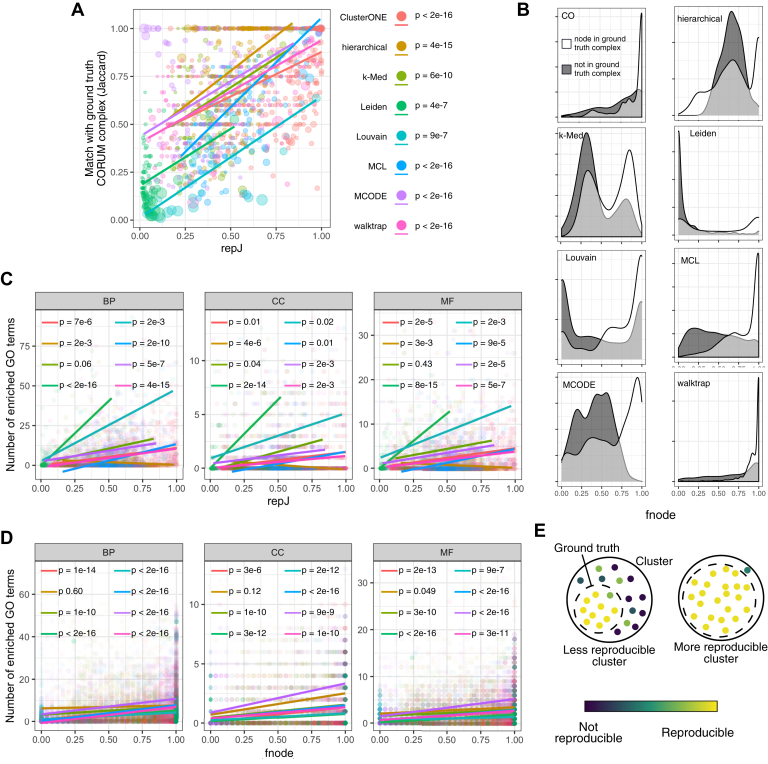
Reproducible clusters and nodes measured by clust.perturb are associated with ground truth communities.A, clusters with high repJ values are more closely associated with a CORUM complex, as measured by Jaccard index. The p-values are for the repJ term in the linear regression model, where CORUM_jaccard (dependent) was predicted by repJ and cluster_size (independent variables). B, density plots of fnode values for nodes in the ground truth CORUM complex (white) and nodes not in ground truth (gray). C, number of enriched GO terms for a cluster correlates with its repJ value. The p-values for repJ term linear regression model, where N_enriched_GO (dependent) was predicted by repJ and cluster_size (independent variables). D, proteins with high fnode tend to share GO terms that their assigned cluster is enriched for. E, nodes “lost” in noise iterations are less likely to be from the ground truth complex, and similarly clusters more tightly associated with a ground truth complex are more reproducible. CO, ClusterONE; GO, Gene Ontology; MCL, Markov clustering. BP, biological process; CC, cellular compartment; CORUM, comprehensive resource of mammalian complexes; MF, molecular function.